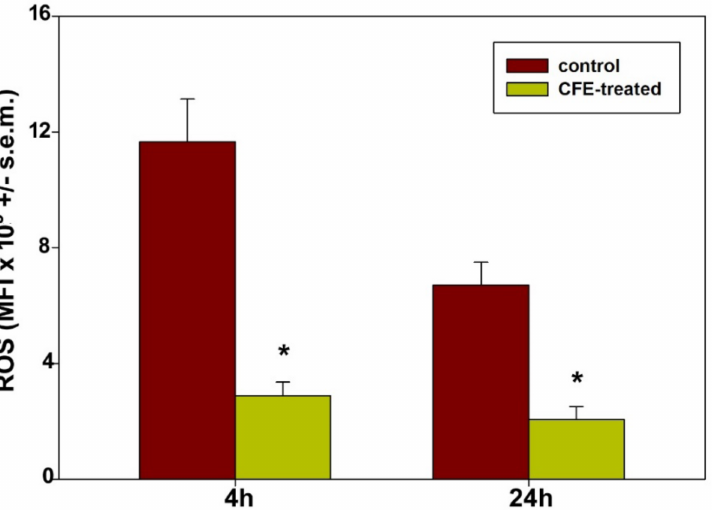
Figure 6. Bar graphs showing the ROS-associated MFI in ROS + cell subpopulations of control and IC 50 24 CFE-treated HepG2 cells for 4 and 24 h. The error bars correspond to the standard error of the mean (s.e.m.) of three independent measurements. * p <